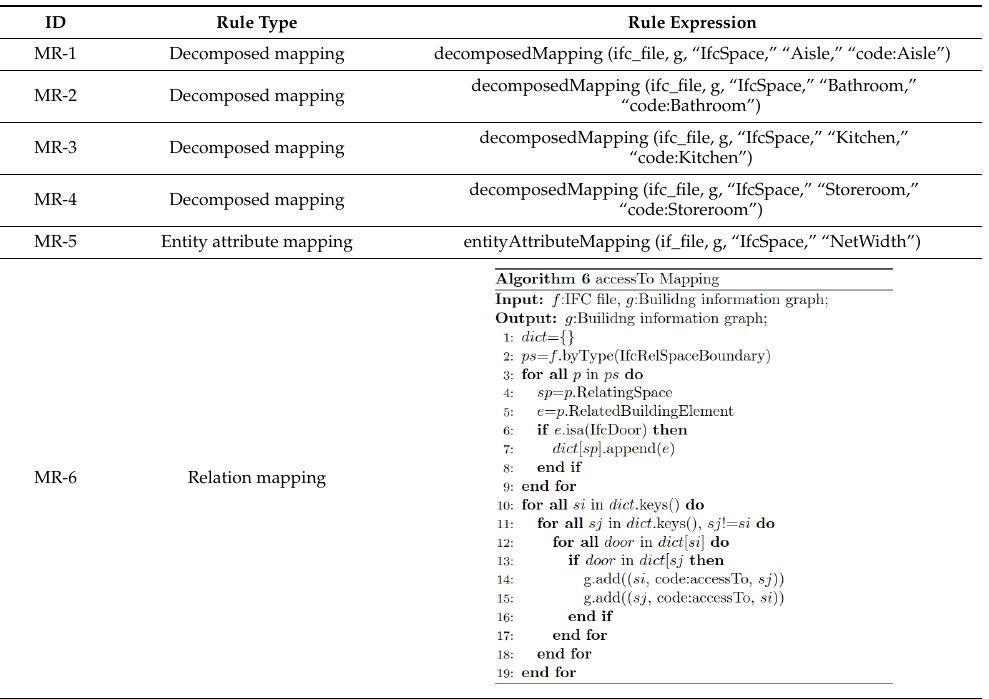
Table 5. Mapping rules developed for clause 5.7.1.3.